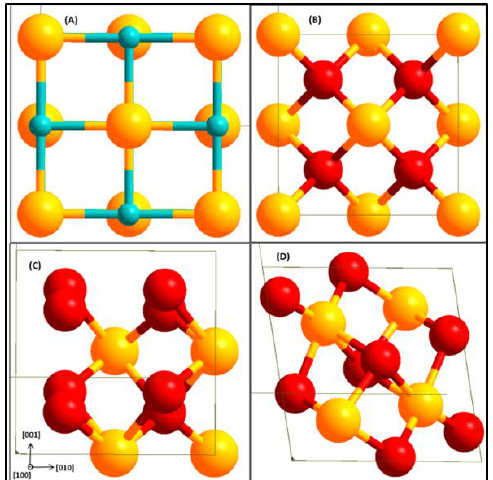
Figure 1. Bulk structures of ZrC ( A ), c -ZrO 2 ( B ), t -ZrO 2 ( C ), and m -ZrO 2 ( D ). Yellow (Zr), light blue (C), and red (O).